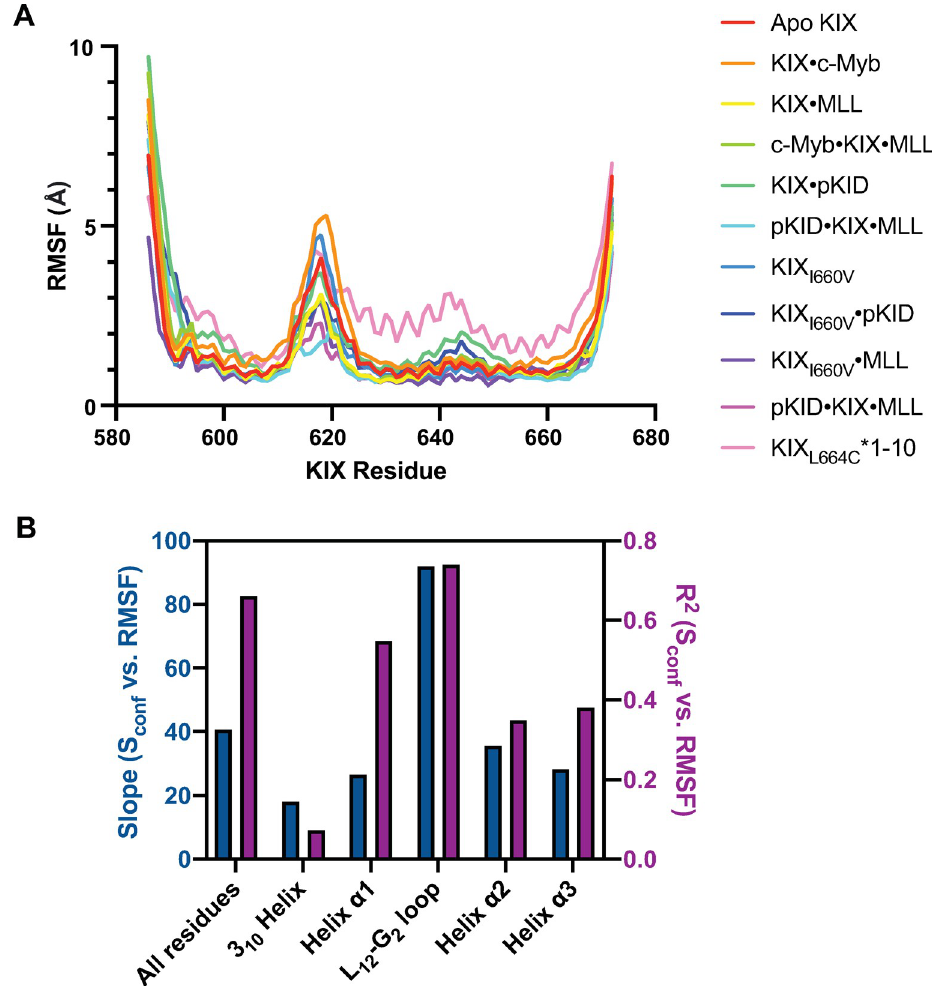
Fig 7. Root mean square fluctuations (RMSF) and conformational entropy. (A) RMSF by KIX residues for all systems tested here. (B) The correlation between RMSF and configurational entropy derived from side chain methyl order parameters were determined. Both the magnitude (slope, dark blue) as well as the goodness of fit (R 2 , purple) of the correlation across different secondary structural elements of KIX show that fluctuations in the L 12 -G 2 loop best correlate to KIX